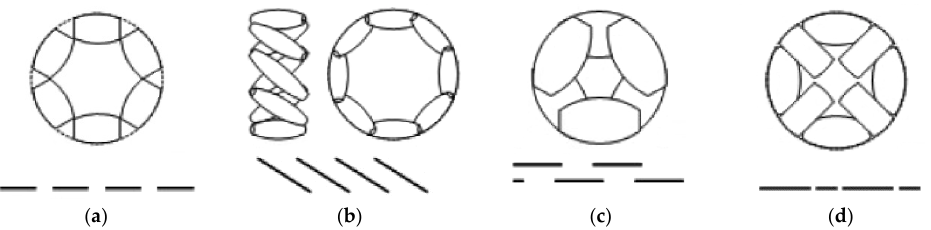
Figure 1. Types of omnidirectional wheels and their traces: ( a ) multiple passive rollers (or inner passive wheels) whose axes are positioned tangent to the main wheel circumference; ( b ) with the rollers arranged in an overlapping way where the contact between the wheels and the ground is continuous; ( c ) based on two overlapping parallel wheels; ( d ) based on using alternated passive rollers with different size and shape.